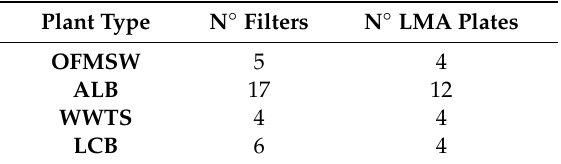
Table 1. Description of the collected samples: plant type, number of filters ( < 0.49 µ m), and number of low melting agar